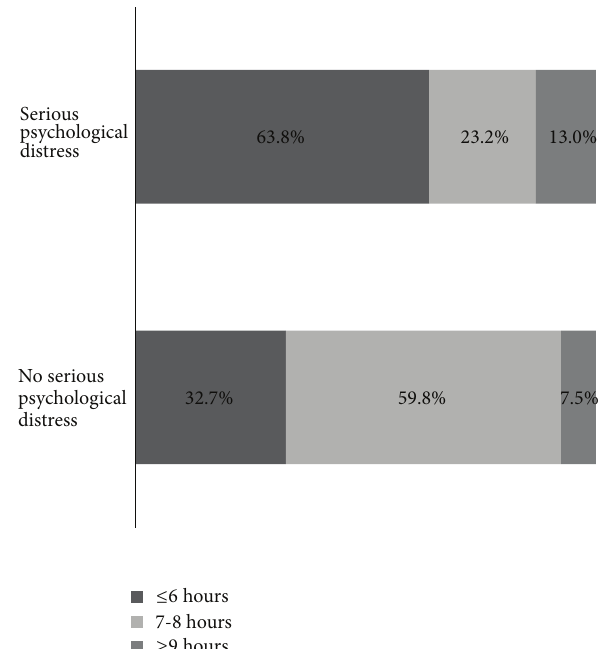
Figure 1: Distribution of average hours sleep in 24-hour period by serious psychological distress among adults aged ≥ 18 years in 5 states, Behavioral Risk Factor Surveillance System, 2013.